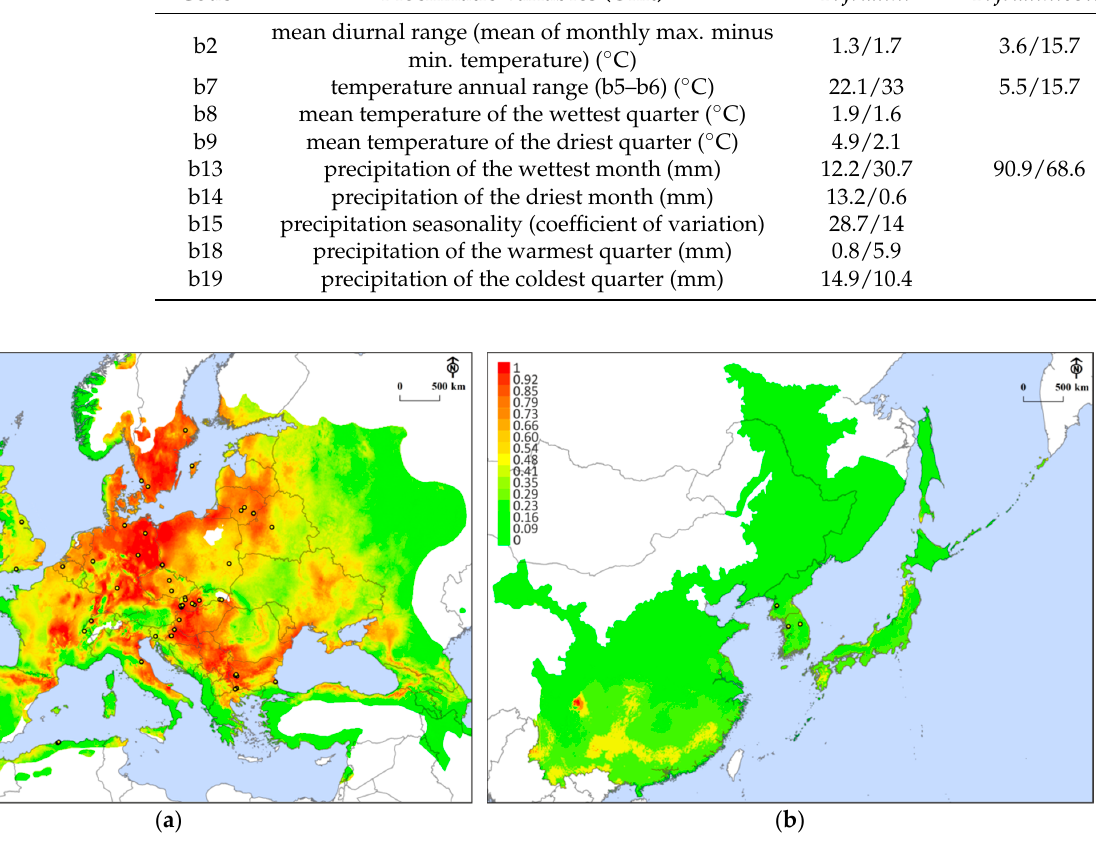
Figure 2. Habitat suitability maps modeled in Maxent and confirmed occurrences: ( a ) Phyllactinia fraxini in Europe, ( b ) P. Figure 2. fraxini in Southeast Asia, ( c ) P. fraxinicola in Europe, and ( d ) P. fraxinicola in Southeast Asia. The horizontal scale bar refers to the probability of distribution (1, high habitat suitability; 0, not suitable). White areas lie outside the natural distribution of Fraxinus host trees.